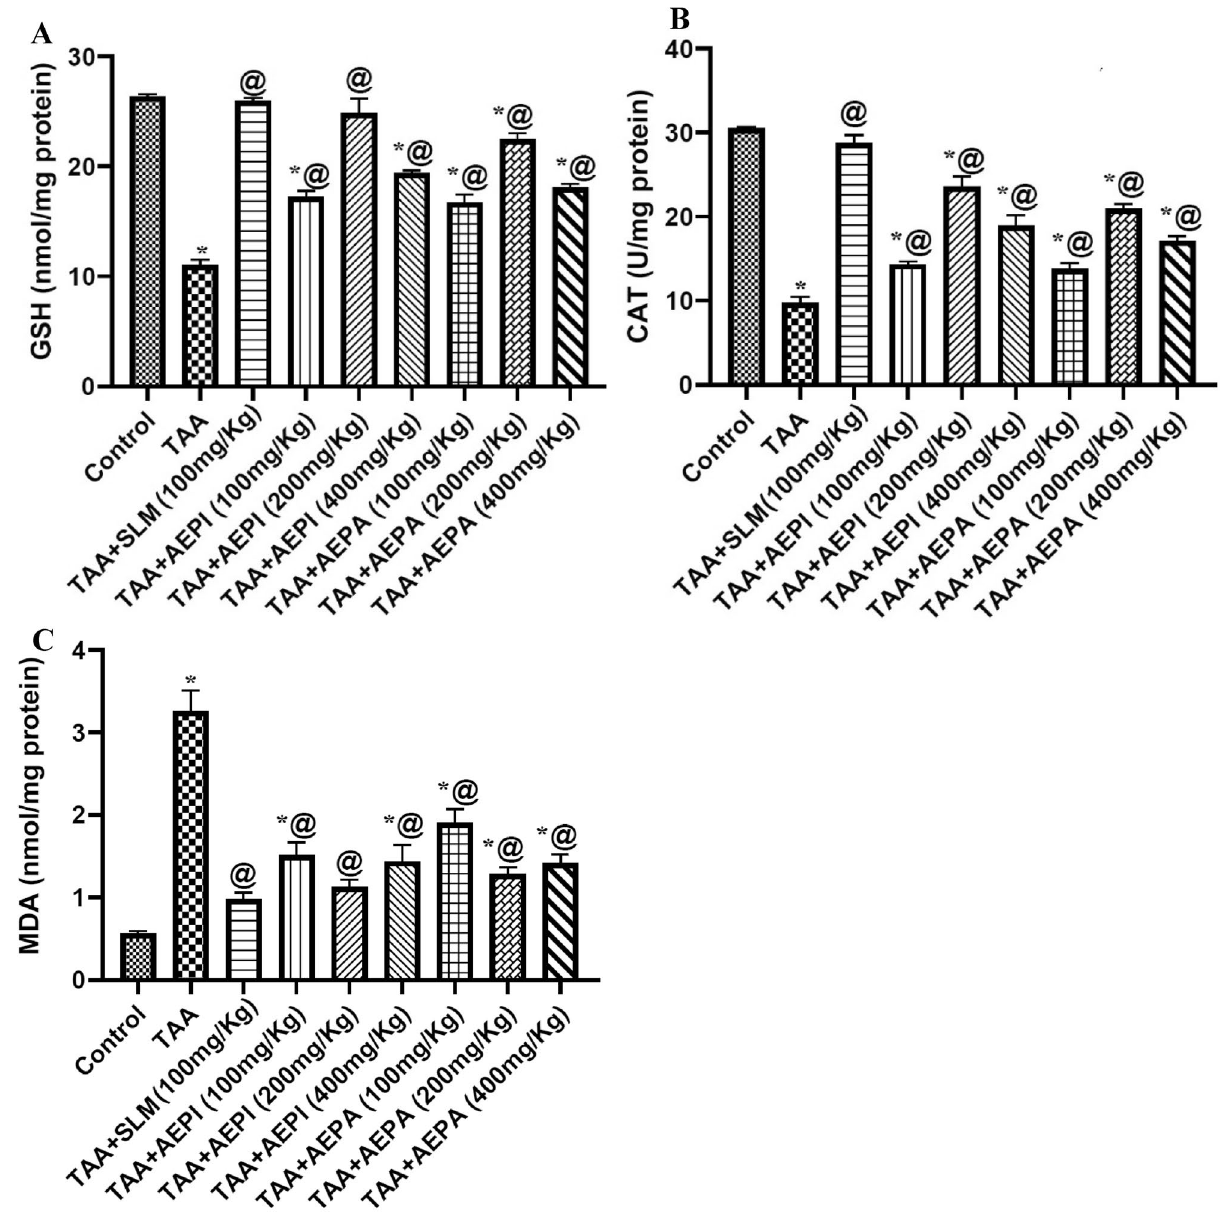
Figure 1. Effects of pretreatment with hydroalcoholic extracts of the aerial parts of P. indica or P. auriculata on the liver contents of oxidative stress markers in TAA-induced liver toxicity in rats. ( A ) reduced glutathione (GSH), ( B ) catalase enzyme (CAT) and ( C ) malondialdehyde (MDA). Animals were given TAA (200 mg/kg/ day; i.p.) on 14th and 15th days. Other regimens were given orally and daily for 15 days. Results were expressed as Mean ± SD, n = 5. SLM: Silymarin, * ,@ Significantly different from normal control and TAA groups at p < 0.05,